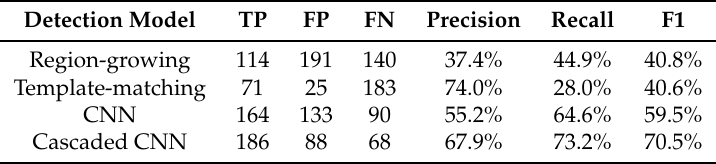
Table 2. The comparisons of Test Area 2.